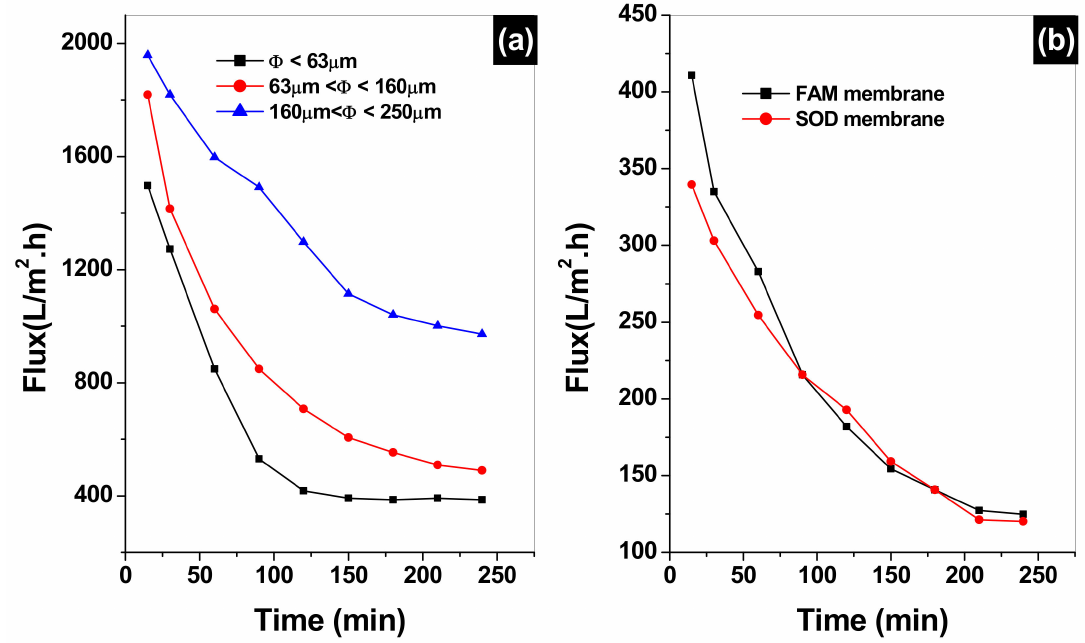
Figure 8. ( a ) Water flux variation versus filtration time for the three supports made from Φ ≤ 63 µ m, 63 µ m ≤ Φ ≤ 160 µ m and 160 µ m ≤ Φ ≤ 250 µ m granulometries, ( b ) sodalite (SOM) and faujasite (FAM) composite zeolite/clay